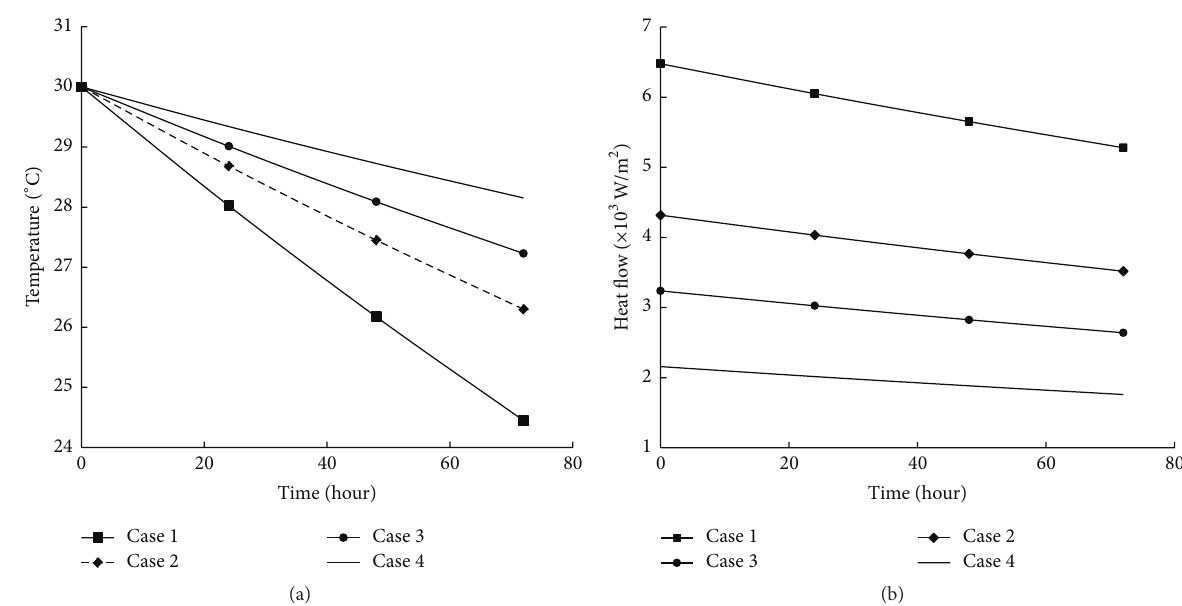
Figure 8: Initial conditions: (a) average temperature variation and (b) average heat flow variation.